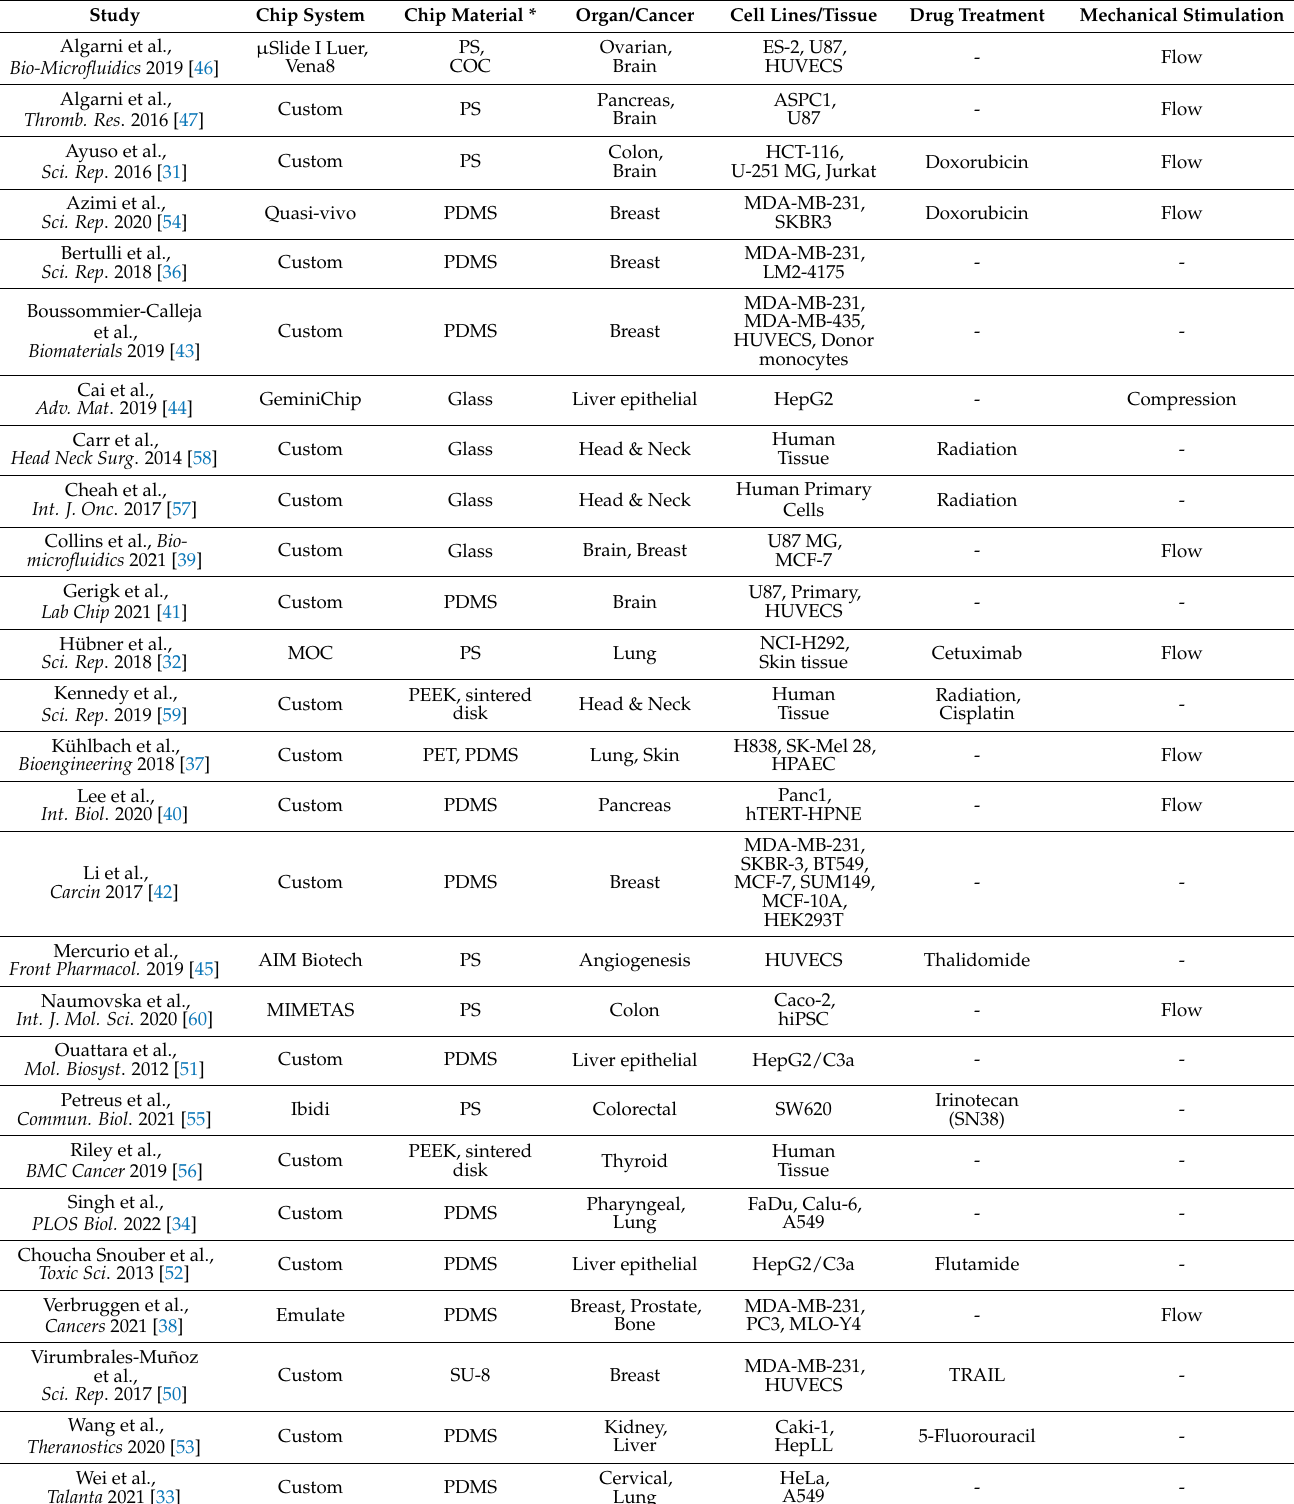
Table 1. Published organ-on-a-chip studies of cancer carried out by UK institutions and companies, demonstrating the breadth of models being developed in